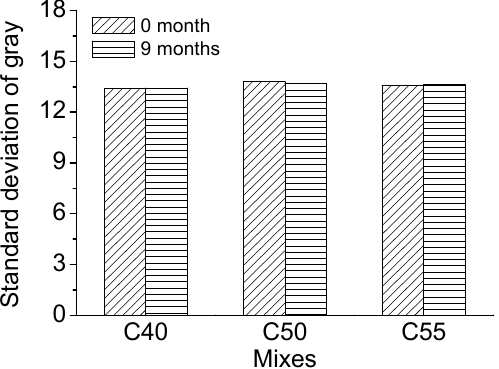
Figure 21. Standard deviation of C40, C50, and C55 exposed to the atmosphere zone after different exposure times.